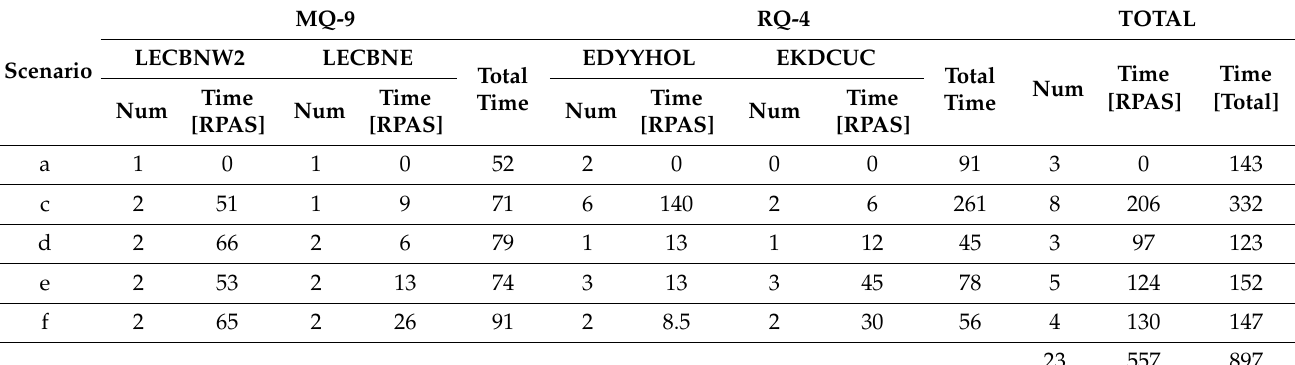
Table 5. Resume table of the contingency-related RPAS/ATC real-time simulations (Run1).